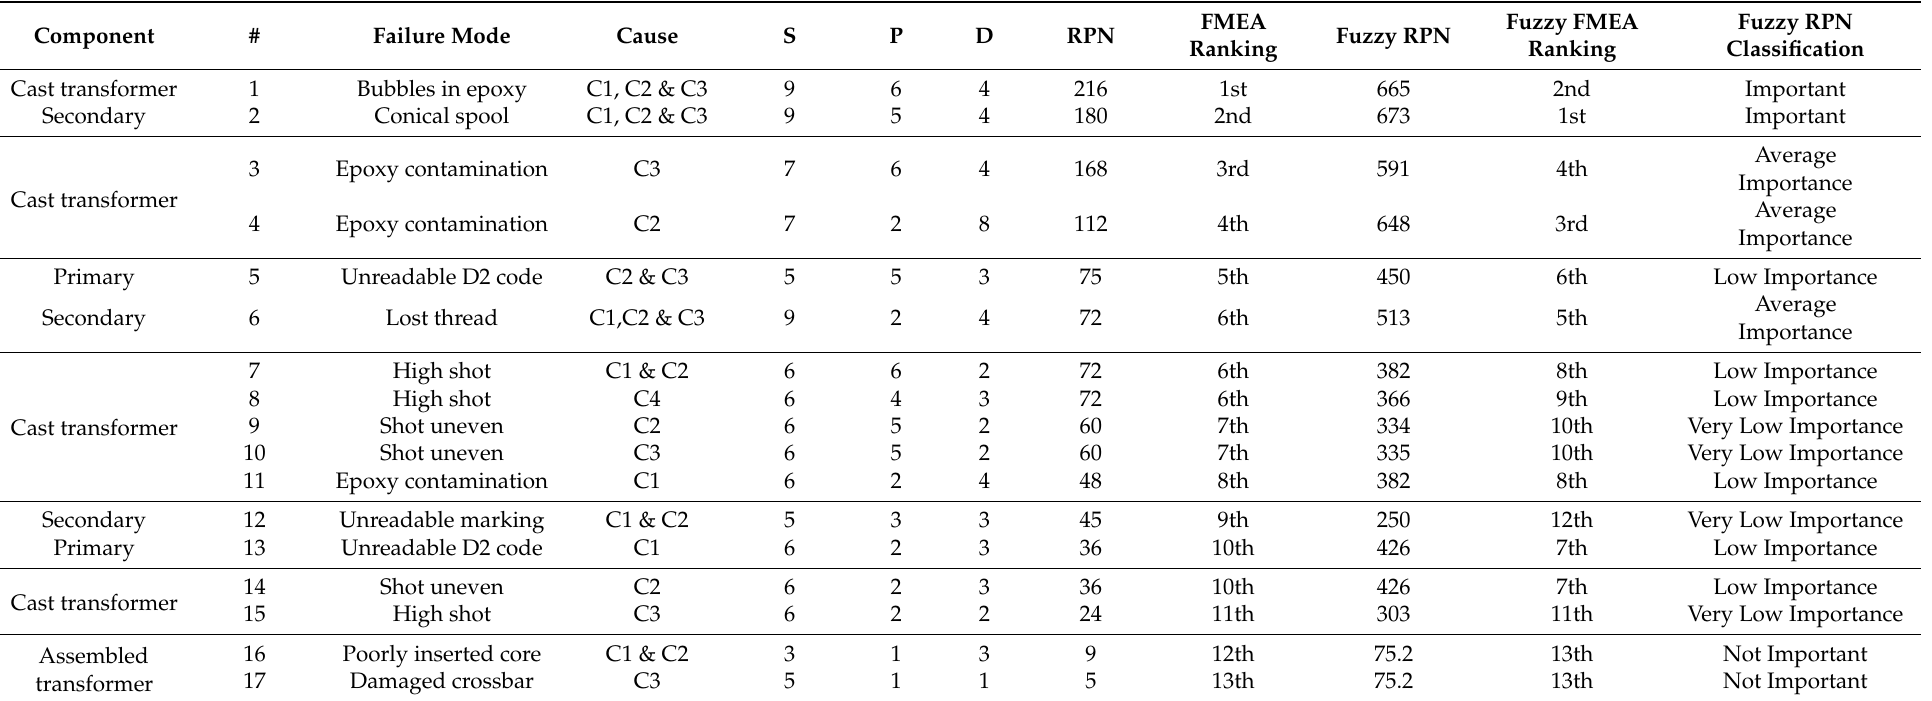
Table 6. Comparison between classic RPN and fuzzy